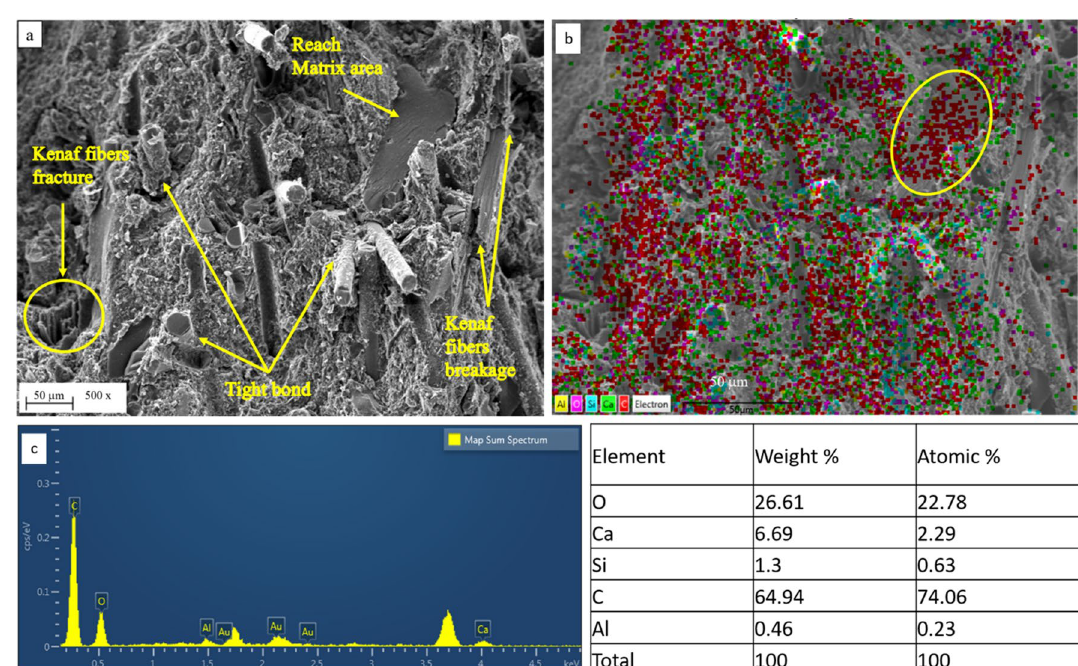
Figure 18. SEM–EDS elemental mapping of flexural fractures in the MCC12 composite, where ( a ) SEM micrographs of flexural fracture on the surface, ( b ) EDS elemental map of composition, and ( c ) EDS spectrum and right table of the atomic and weight percentages of various